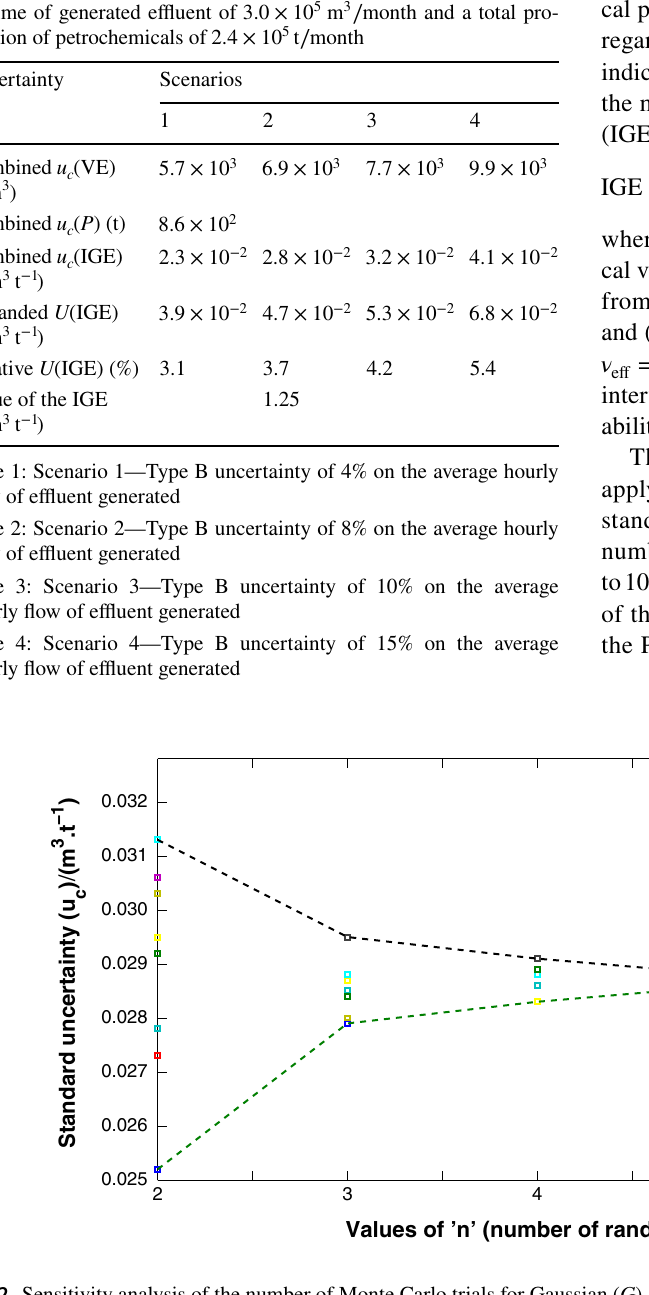
Table 1 Scenarios for the assessment of the uncertainty of IGE for a volume of generated effluent of duction of petrochemicals of